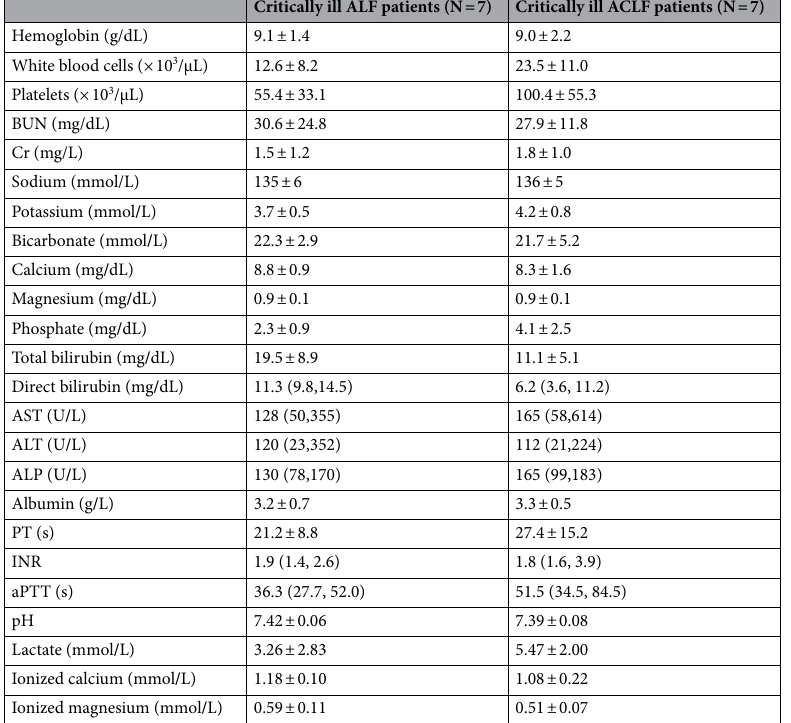
Table 2. Baseline laboratory data. ALT alanine aminotransferase, ALP alkaline phosphatase, aPTT activated partial thromboplastin time, AST aspartate aminotransferase, BUN blood urea concentration, Cr creatinine, INR international normalized ratio, PT prothrombin time. Data are represented as mean ± SD or median (IQR).